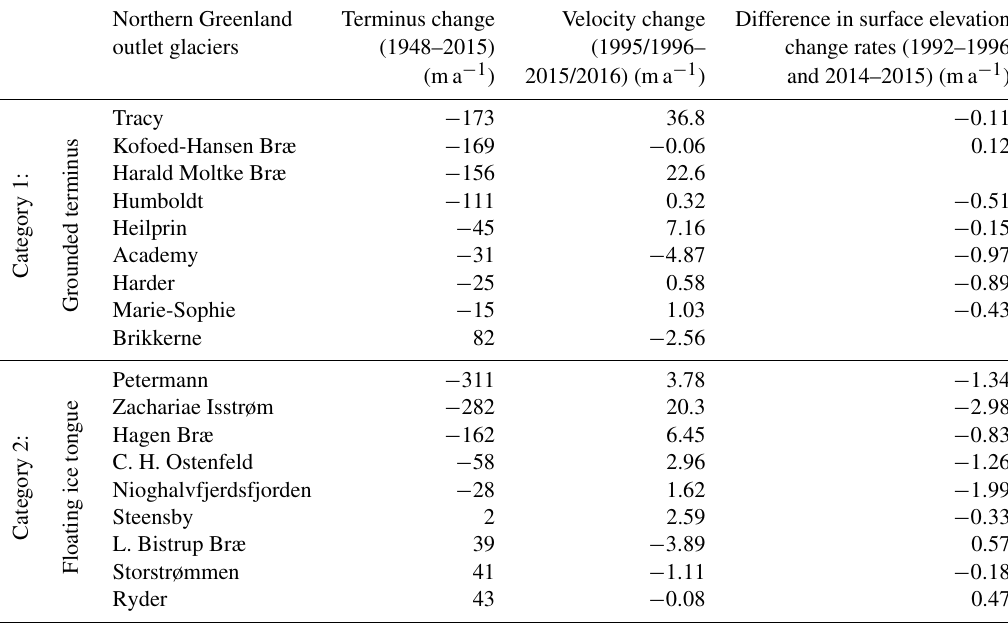
Figure 3. Overall mean rate of terminus change (ma − 1 ) at 18 outlet glaciers in northern Greenland from 1948 to 2015. Green circles represent glaciers which have undergone overall advance during the record, while yellow to red circles represent increasing retreat rates from 0 to larger than − 300ma − 1 . Table 1. Summary data for 18 northern Greenland outlet glaciers, ordered according to terminus type and by frontal position rate (from high retreat to high advance). Annual rates of terminus change are given for the entire record (1948–2015). Average velocity change along each glacier centre line from winter 1995/1996 to 2015/2016. Average surface elevation change rates along each glacier centre line were differenced from the earliest record (1992–1996) and the most recent